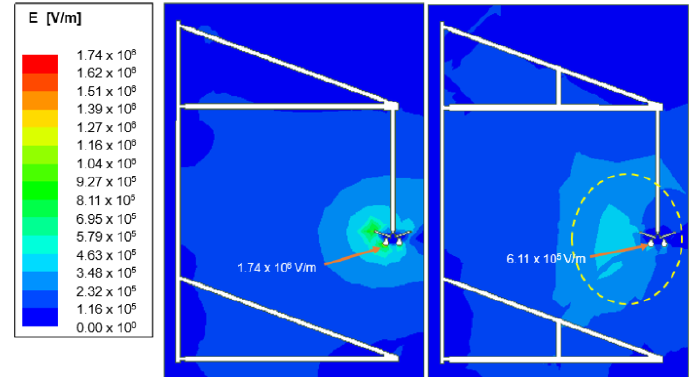
Figure 12. Electric field distribution due to the lightning impulse voltage (BIL).